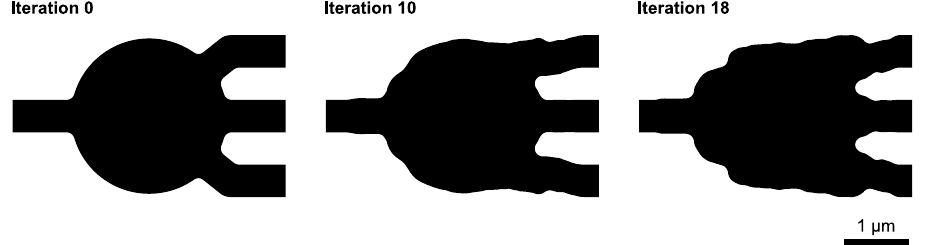
Figure 1. Intermediate steps in the optimization process for the 1 × 3 splitter. Starting with a star-shaped geometry, the optimization converged in 18 iterations. The minimum radius of curvature in the design was set to 100 nm. Regions with Si are denoted in black, and SiO 2 is denoted in